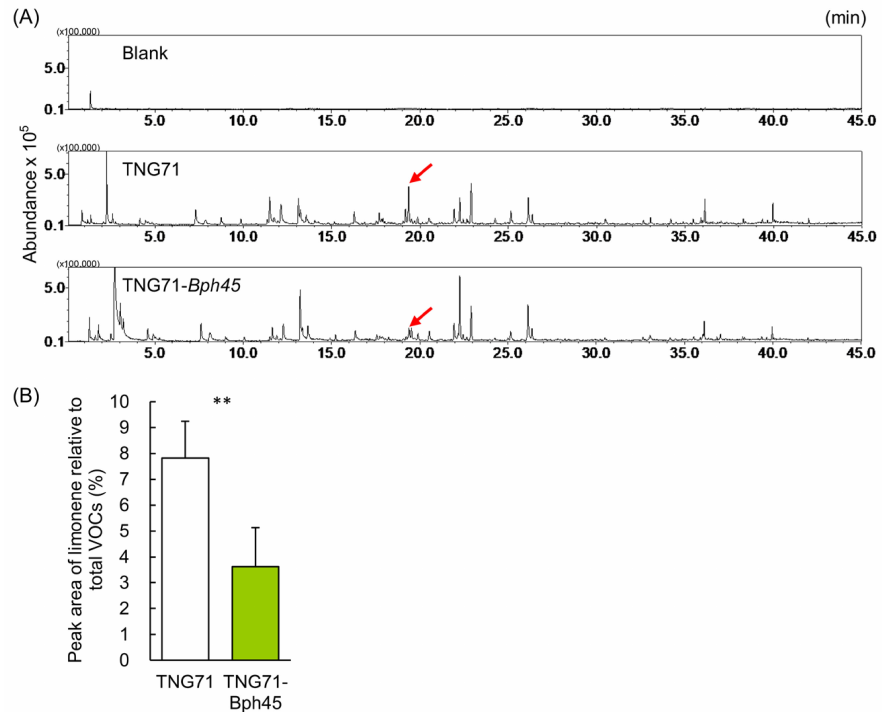
Figure 3. Comparison of the Volatile Organic Compounds emitted by rice lines using GC-MS. Five grams of 40-day-old rice leaves were incubated with an SPME probe overnight at room temperature and then analyzed by GC-MS. ( A ) Typical chromatograms were obtained from the blank (top), TNG71 (middle), or TNG71- Bph45 (bottom). The red arrow indicates the peak of limonene that differed in amount consistently between TNG71 and TNG71- Bph45 . ( B ) The relative amount of limonene was semi-quantified according to its peak area in the GC-MS profile. Statistical analysis was performed using Student’s unpaired t -test (N = 5). ** p <